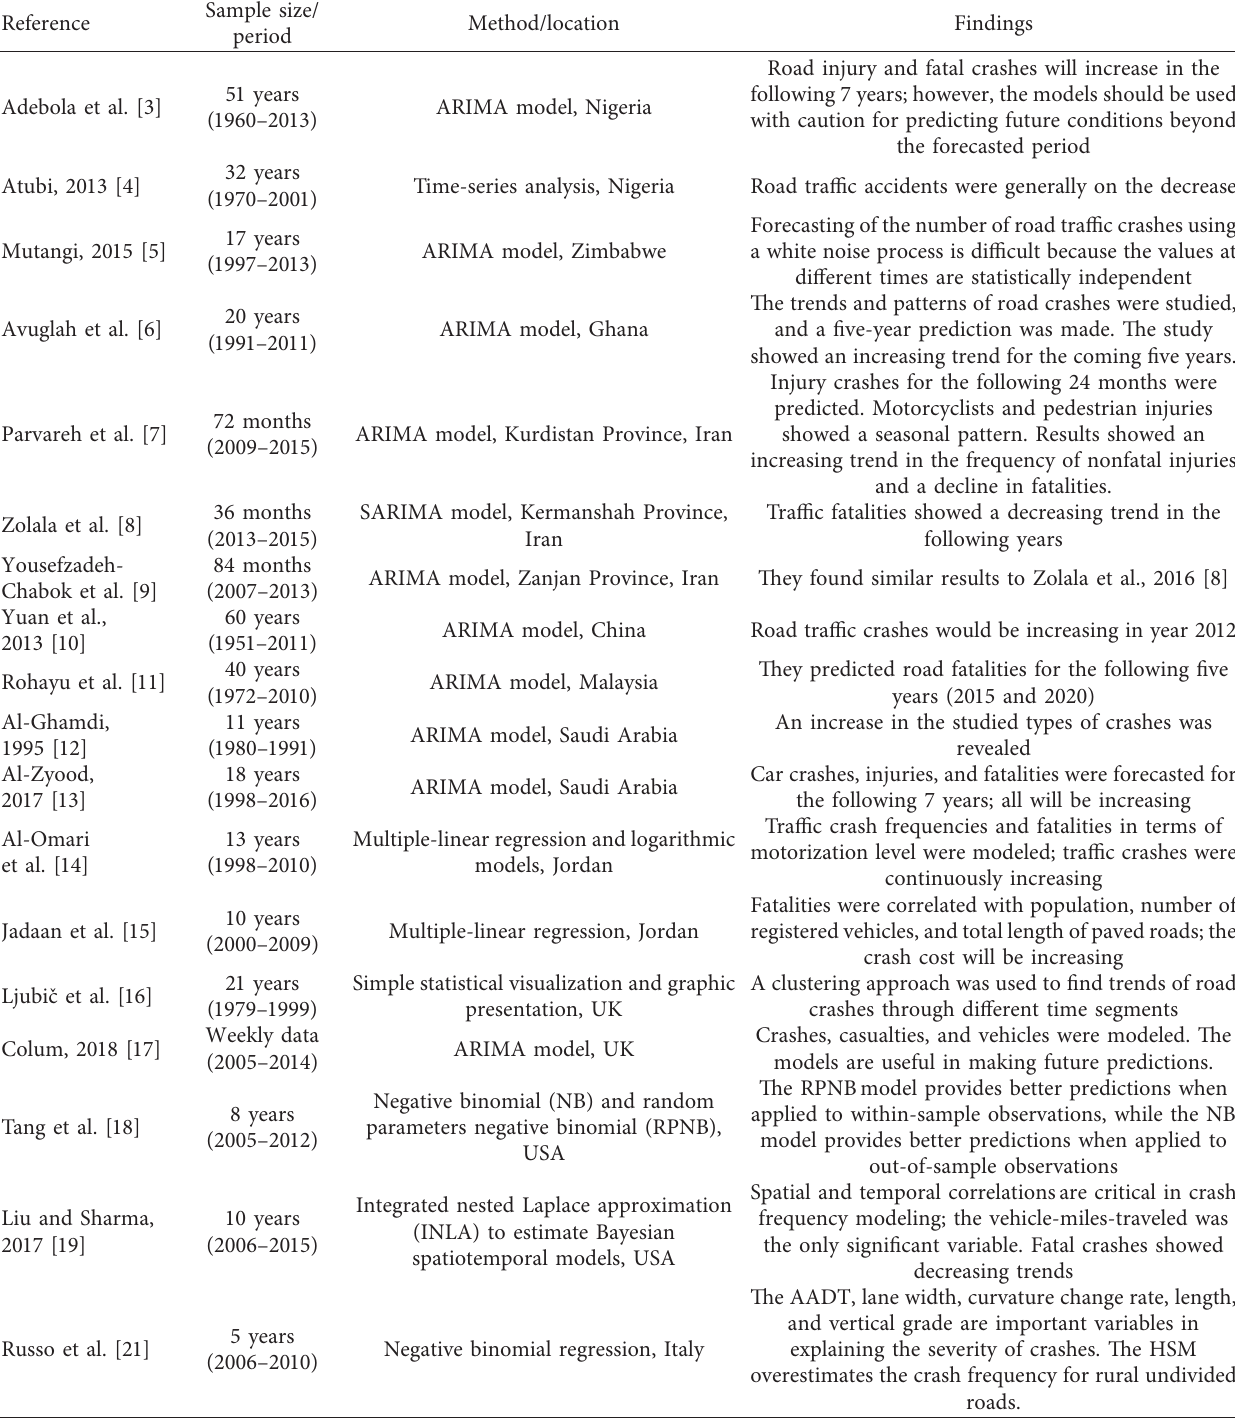
Table 1: Summary of literature related to sample size, models, and